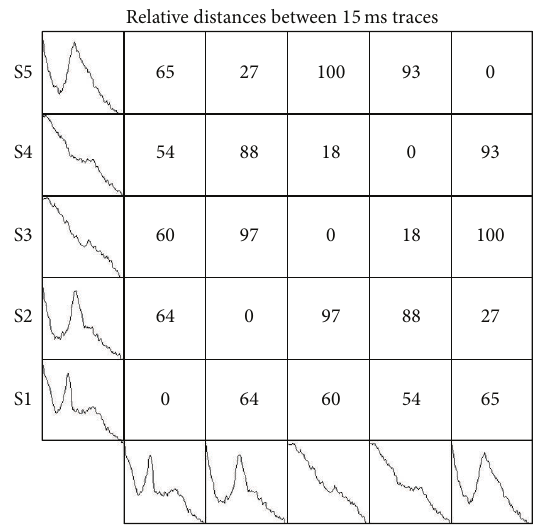
Figure 2: Schematic representation of the numeric designation of F- wave recurrence. Note that the numbers increase as the discrepancy between the configurations of the responses increases varying from 100 with marked differences to 0 for similar responses. These values were then used to determine which values were included in the recurrence matrix (the radius). As discussed in the text, lower values would be considered recurrent and higher values nonrecurrent. S1–5 represent individual F-wave